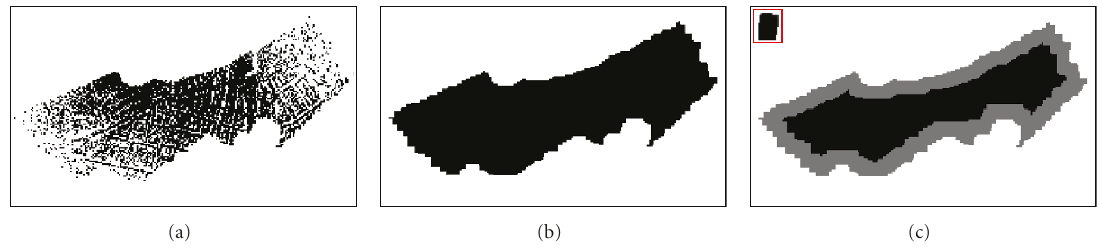
Figure 2: Creation of the binary mask for the tests. (a) Initialized mask with black pixels if a 3D laser point is found in the defined neighborhood. (b) Mask after the closing operation. (c) The gray area is eroded by means of a mask of the landmark as structured element (upper left, red box). The final mask consists of the residual black pixels.